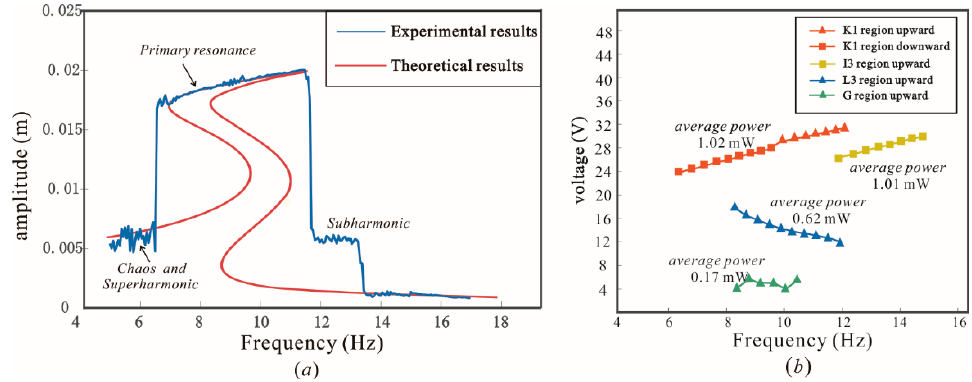
Figure 11. ( a ) The amplitude–response of the experimental prototype vs. theoretical results; and ( b ) Output power. ( b ) Output